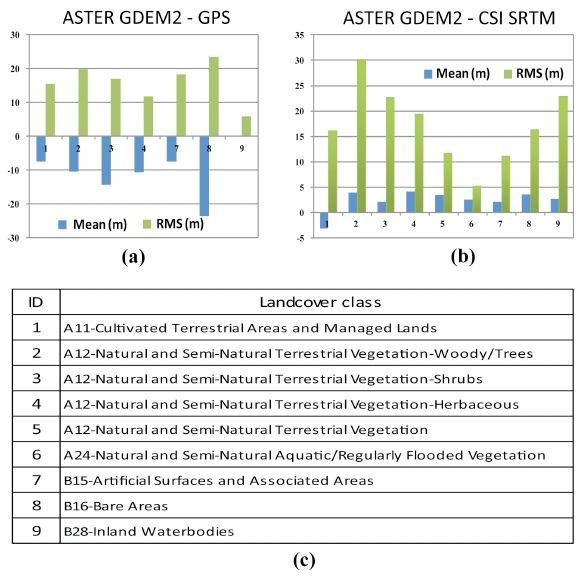
Figure 5. a and b show the landcover class assessment for the elevation differences (GDEM-GPS and GDEM-SRTM, respectively) over the five study areas. (c) The UN Land Cover Classification System (LCCS) landcover classes used as a mask for elevation comparison and ID corresponding to the value of horizontal axis in (a) and (b).